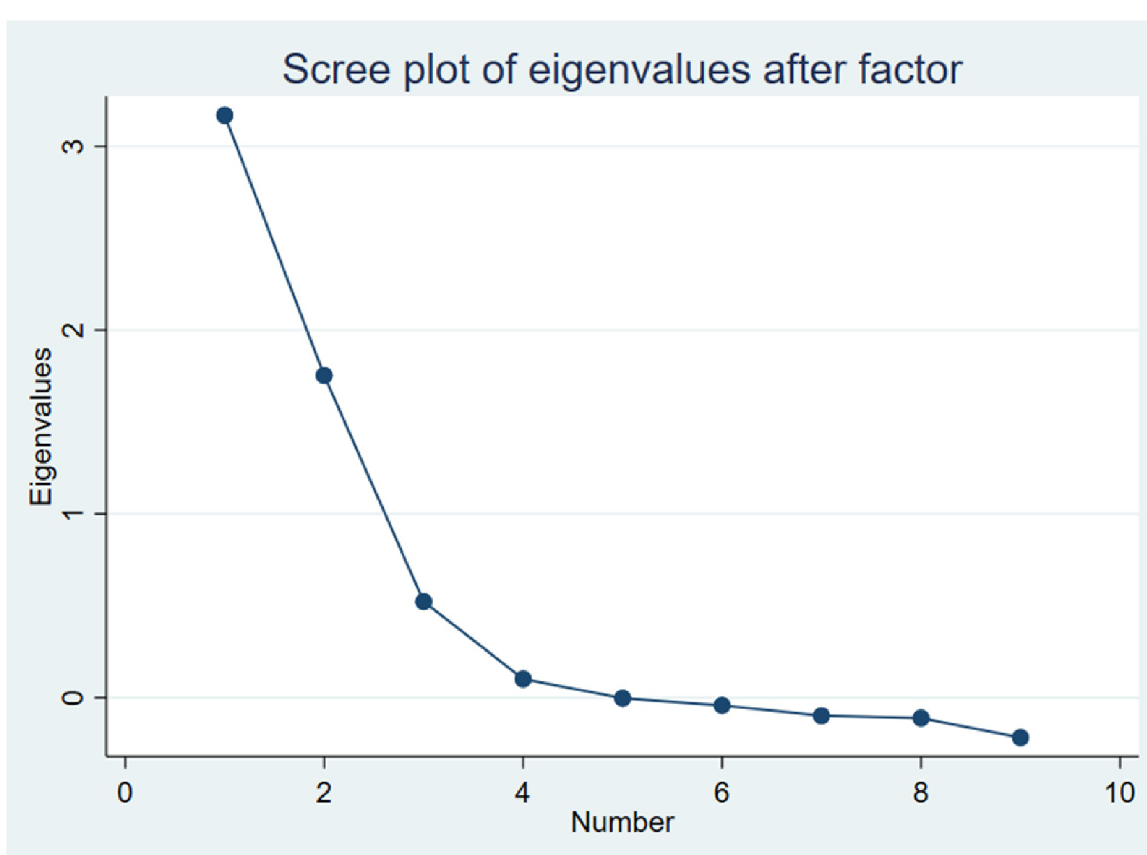
Fig 2. Scree plot of eigenvalues for the exploratory factor